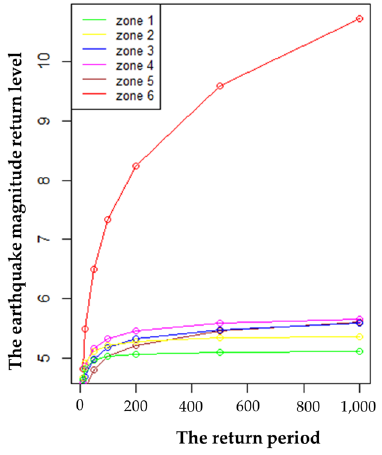
Figure 14. The earthquake magnitude return level in Cluster Type II.